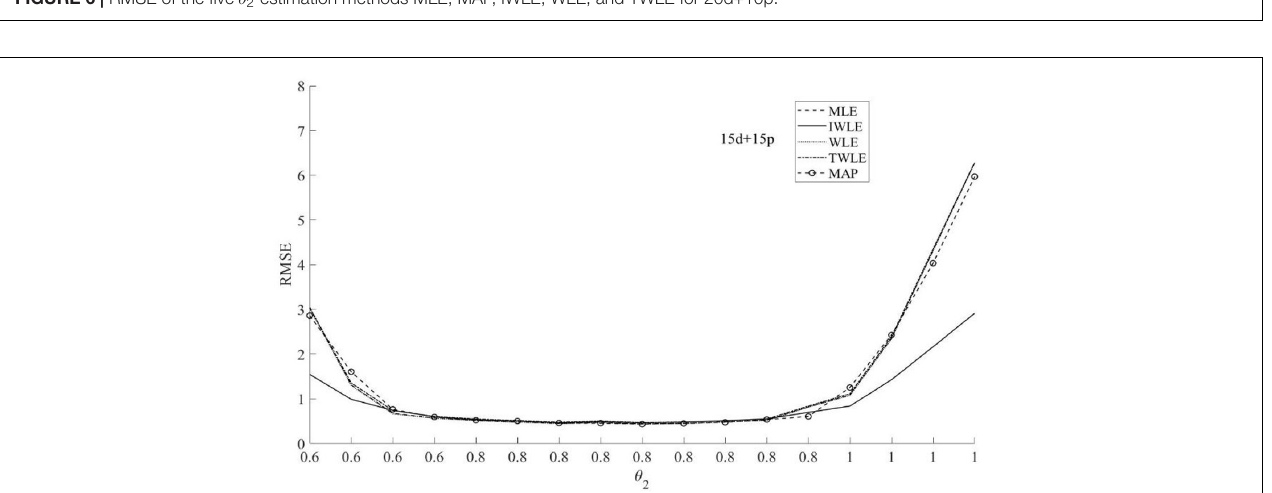
FIGURE 6 | RMSE of the five θ 2 estimation methods MLE, MAP, IWLE, WLE, and TWLE for 20d+10p.